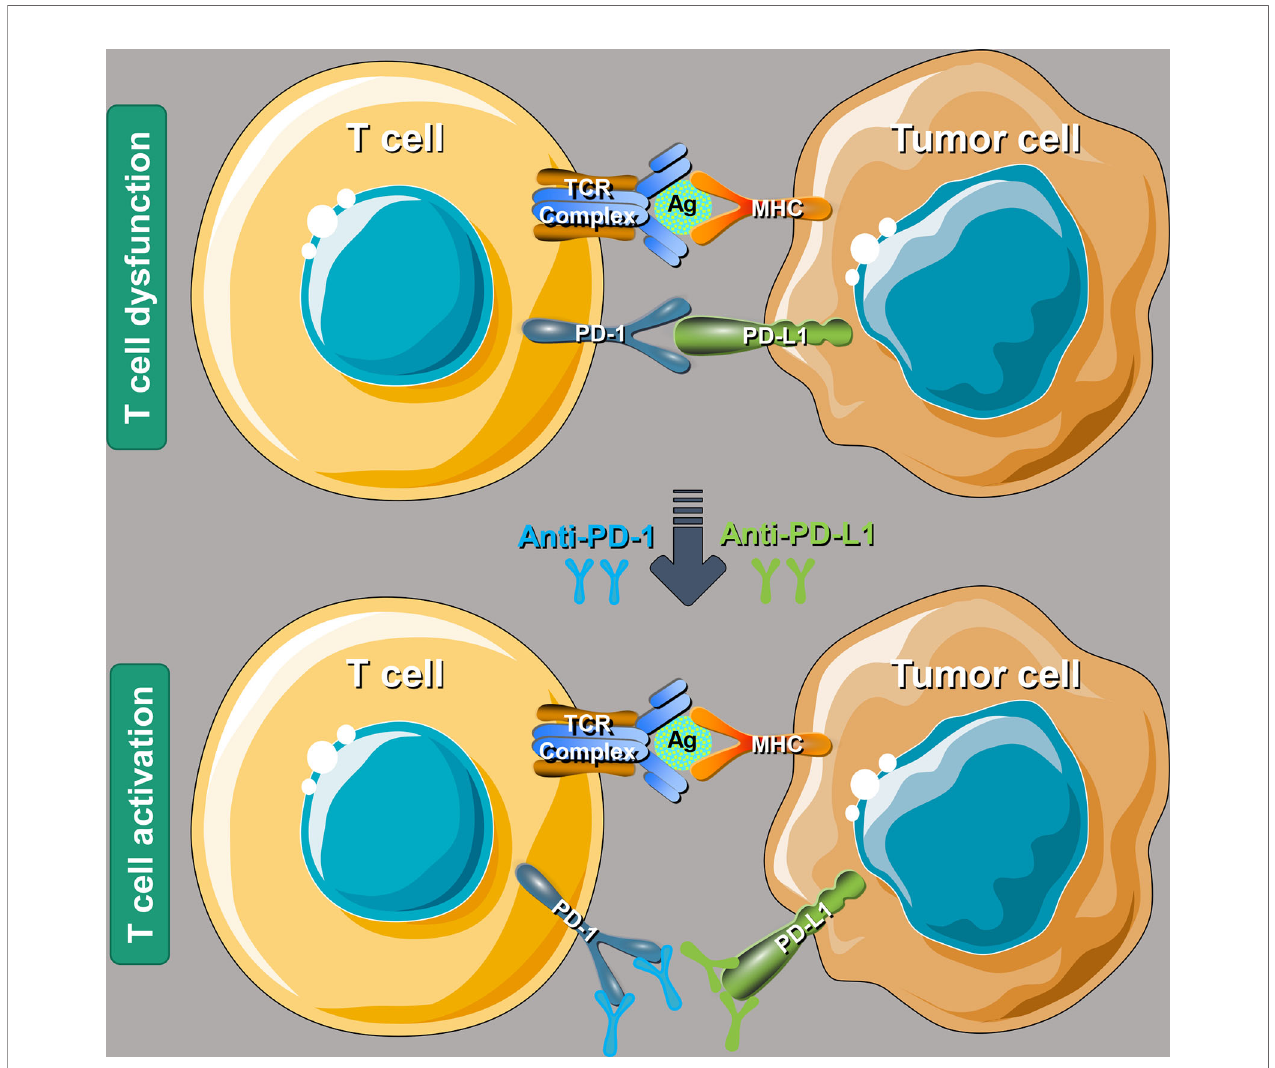
FIGURE 1 | A schematic diagram of the molecular mechanism using PD-1/PD-L1 ICIs to rescue T cell functions. PD-1, programmed cell death-1; PD-L1, programmed death-ligand 1; ICIs, immune checkpoint inhibitors; TCR, T cell receptor; Ag, antigen; MHC, major histocompatibility